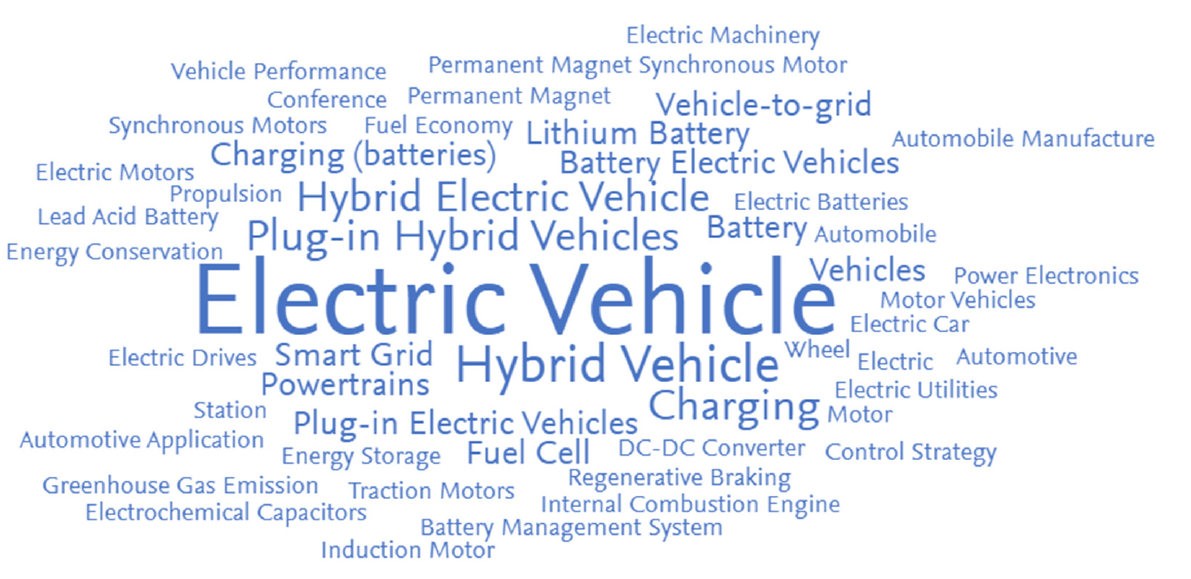
Figure 4. Key phrases based on XEV publications in 2012 .